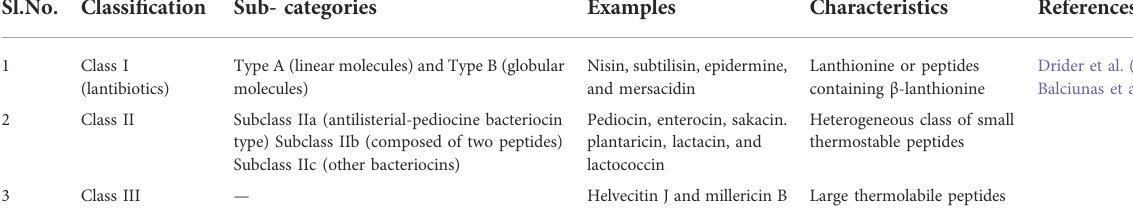
TABLE 1 Example of bacteriocin classi fi cation.